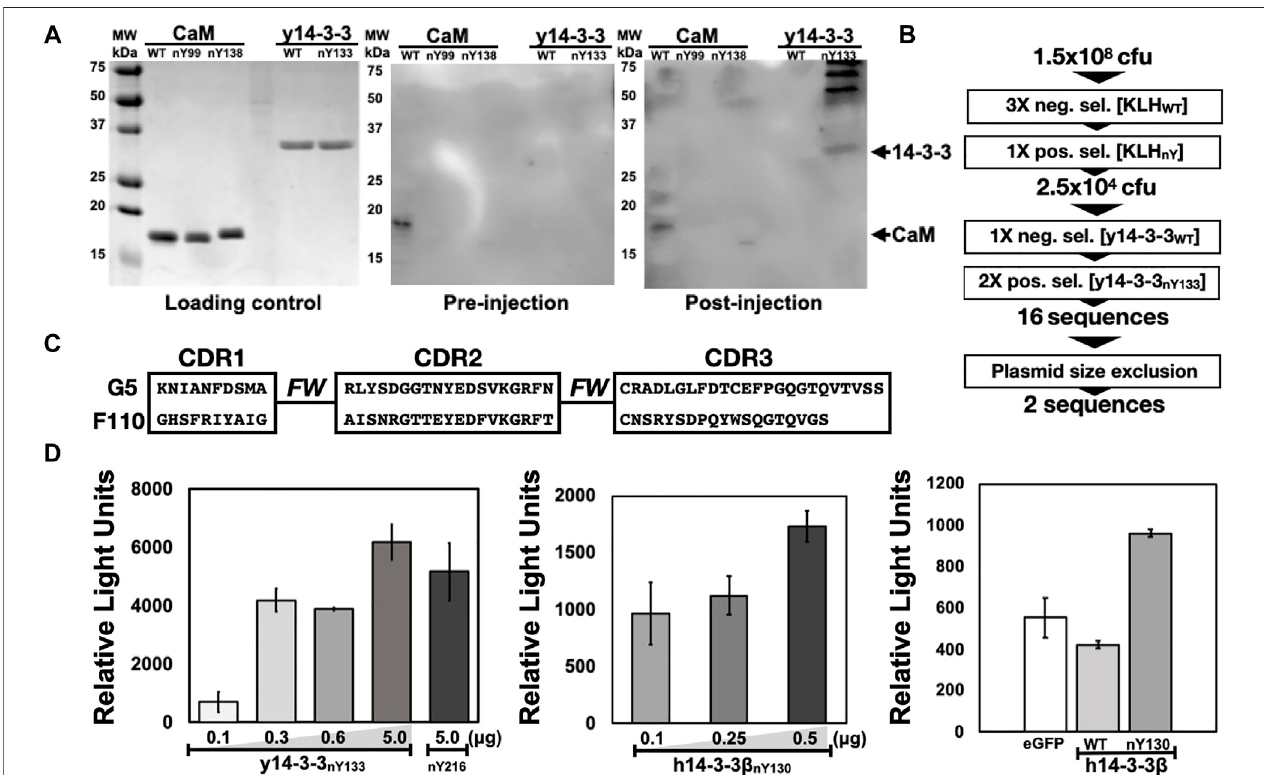
FIGURE2| SelectionandpreliminaryvalidationofNb-G5. (A) Serumanalysisofinjectedanimalagainstnitratedtargets.Fiveproteintargets(WTandnitroTyr,listed at top of gel) were resolved with SDS-PAGE. Gels were either stained (Loading control) or transferred to a PVDF membrane and incubated with serum from before injections (pre-injection) or after (post-injection). These membranes were probed with HRP-conjugated anti-llama primary and visualized. Arrows indicate the expected migrationofproteintargets. (B) Schematicofselectionswithfull-length,foldednitroTyr14-3-3.Includedisthenumberofcfuorsequencesobtainedaftersigni fi cant rounds. (C) CDR regions of Nb-G5 and Nb-F110. “ FW ” indicates the framework region of the Nbs. Full sequences are found in Supplemental Figure S2 . (D) ELISA of Nb-G5 nitrated 14-3-3. Increasing amounts of His-tagged y14-3-3 β nitroY133 (left panel) 14-3-3 β nitroY130 (middle panel) were immobilized on a nickel-coated ELISA plate and incubated with NB-G5 (25 μ g/ml) in TBST followed by incubation with HRP-conjugated anti-llama primary antibody. Right panel: His-tagged sfGFP, 14-3-3 β WT and 14-3-3 β nitroY130 (0.25 μ g). were immobilized on anickel-coated ELISAplate and incubated with NB-G5 (25 μ g/ml)in TBST followed by incubation with HRP- conjugated anti-llama primary